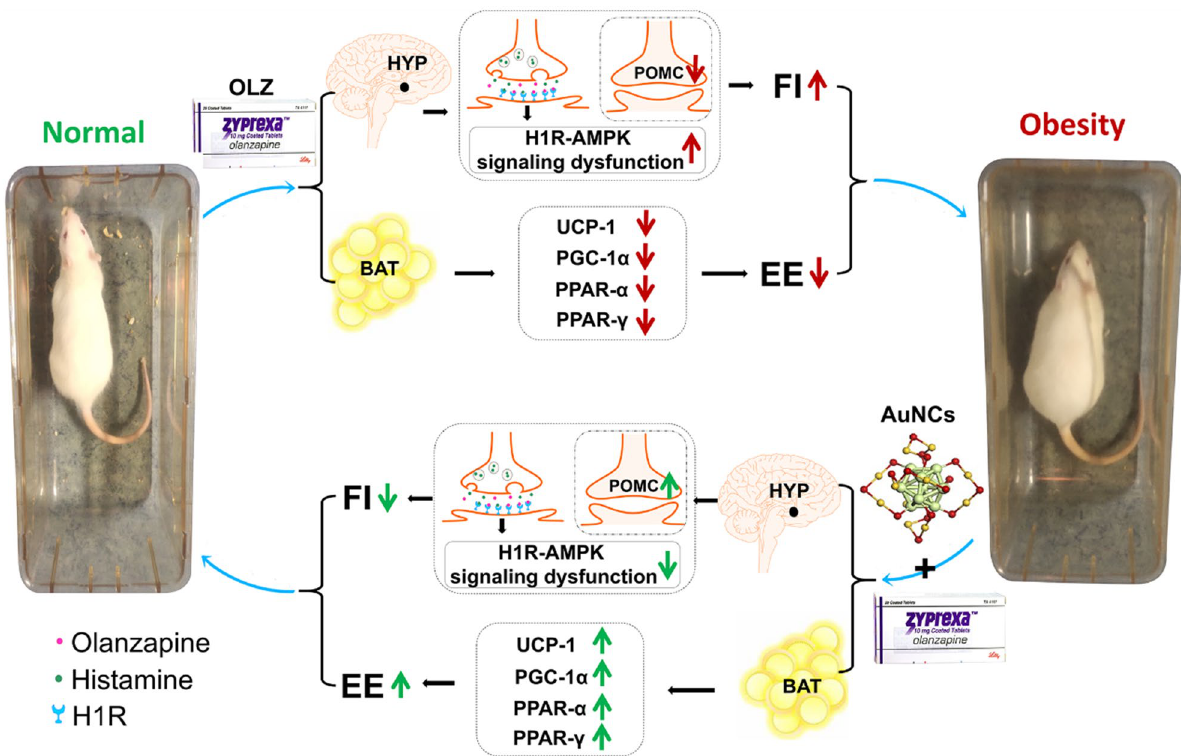
Figure 7. Scheme and potential mechanisms of AuNCs eliminating olanzapine-induced obesity. When olanzapine treated rats were co-treated with AuNCs, AuNCs suppressed hypothalamic H1R-AMPK signaling dysfunction and increasing POMC expression, thus reducing hyperphagia and weight gain. Moreover, AuNCs upregulated the protein expression of UCP-1, PGC-1α, PPAR-α and PPAR-γ in the BAT, and these effects may induce increased energy expenditure and reduced weight gain. HYP hypothalamus, H1R Histamine H1 receptor, AMPK AMP-activated protein kinase, POMC proopiomelanocortin, BAT brown adipose tissue, UCP- 1 uncoupling protein 1, PGC-1α peroxisome proliferator-activated receptor gamma coactivator-1α, PPAR-α peroxisome proliferators-activated receptor α, PPAR-γ peroxisome proliferators-activated receptor γ, EE energy expenditure, FI food